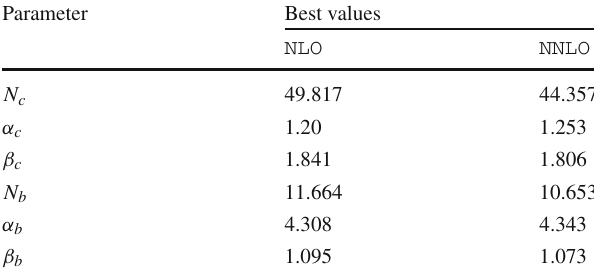
Table 3 The optimal values for the input parameters of the D 0 -FF (4) = 18 . 5 GeV 2 determined by QCD analysis of the at the initial scale μ 2 0